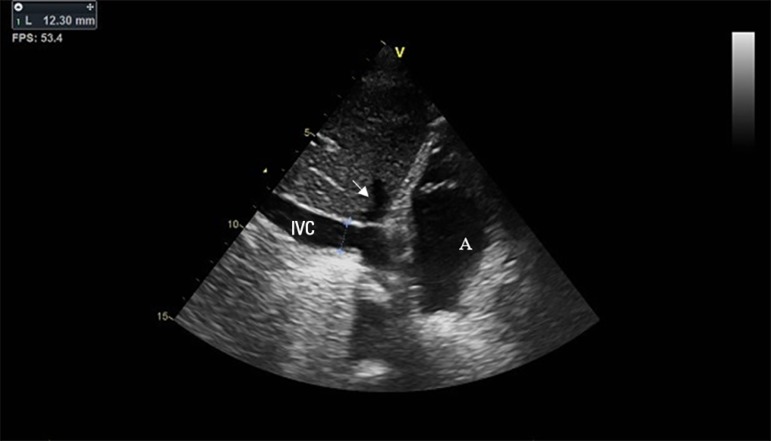
Inferior vena cava diameter measurement technique.The inferior vena cava should be measured in two-dimensional mode at
the subcostal window using the long axis distal to the hepatic vein
(arrow), approximately 1 - 3cm from the entrance of the inferior
vena cava in the right atrium (A). Measurements near the right
atrium entrance or near the diaphragm should be avoided. Its
diameter can also be measured in M mode simultaneously with the
two-dimensional mode to ensure the perfect alignment of the probe,
perpendicular to the long axis of the inferior vena cava. In
patients under invasive mechanical ventilation, the diameter of the
inferior vena cava at the end of inspiration (maximal diameter) and
at the end of expiration (minimum diameter) is measured to calculate
the distensibility index. The probe must be kept in a fixed position
during the respiratory cycle. Image obtained with a GE Vivid T8
echocardiograph. IVC - inferior vena cava.